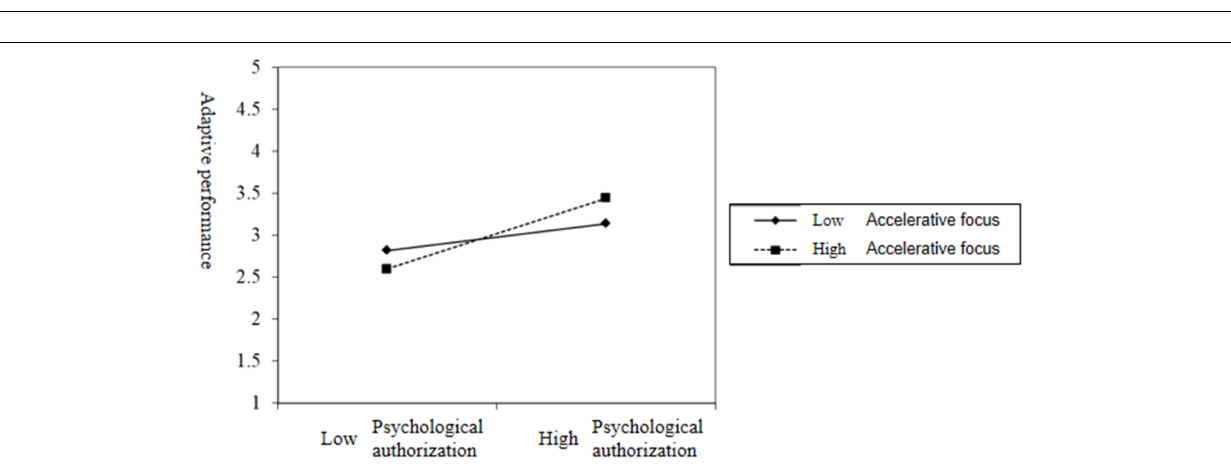
FIGURE 2 | Mediating action path diagram of structural. *** means p < 0.001.